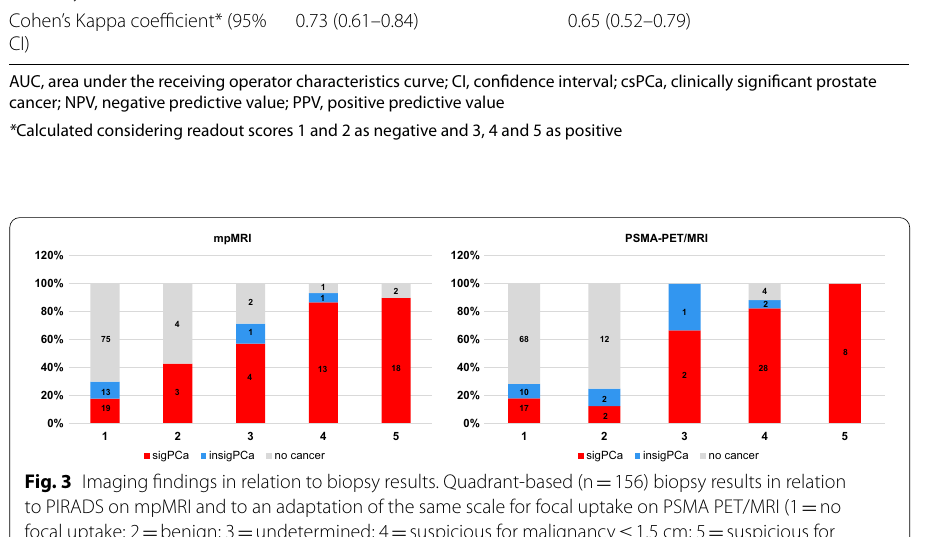
156) biopsy results in relation = no = 1.5 cm; 5 suspicious for ≤ = 3 4); ciPCa clinically insignificant ≥ + =